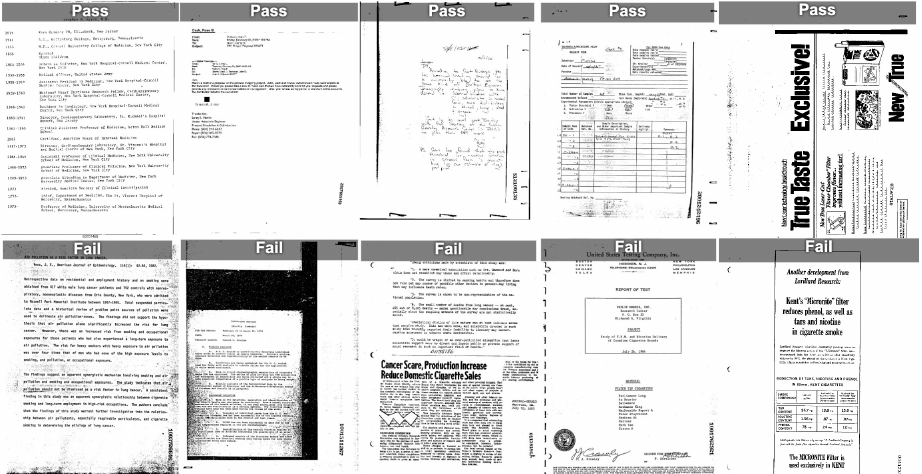
Figure 9. This figure is a collection of 10 different images taken randomly from the dataset, in which 5 of them are successfully classified, while the other 5 were incorrectly classified. The potential reasons for failure in identifying the classes of these input images are discussed in detail in Section 5.